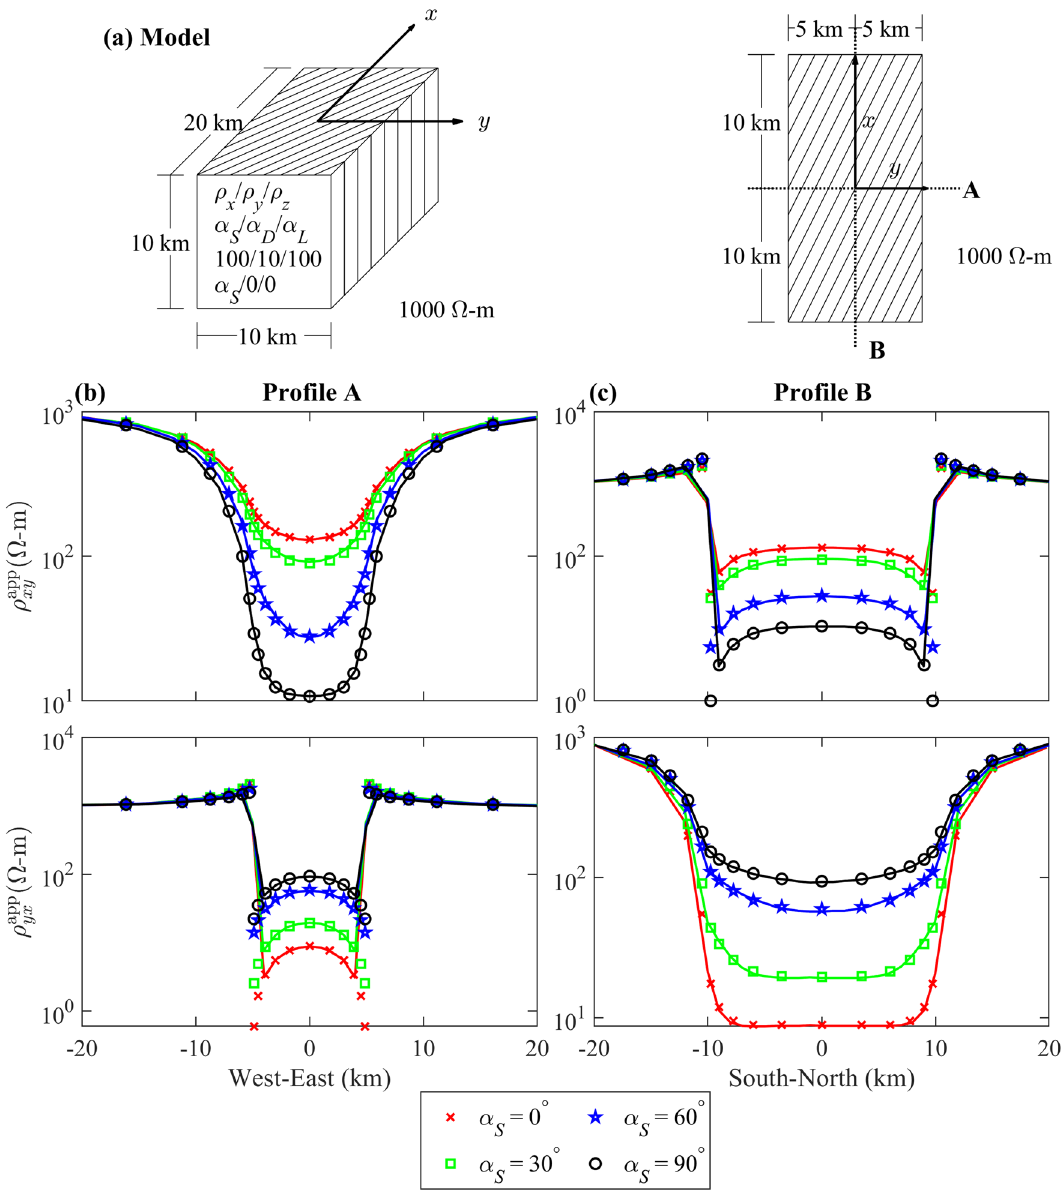
Fig. 16 a 3‑D view and top view of the 3‑D prism model of Han et al. (2018). b Apparent resistivities with various values of strike angles α s along profile A, and c along profile